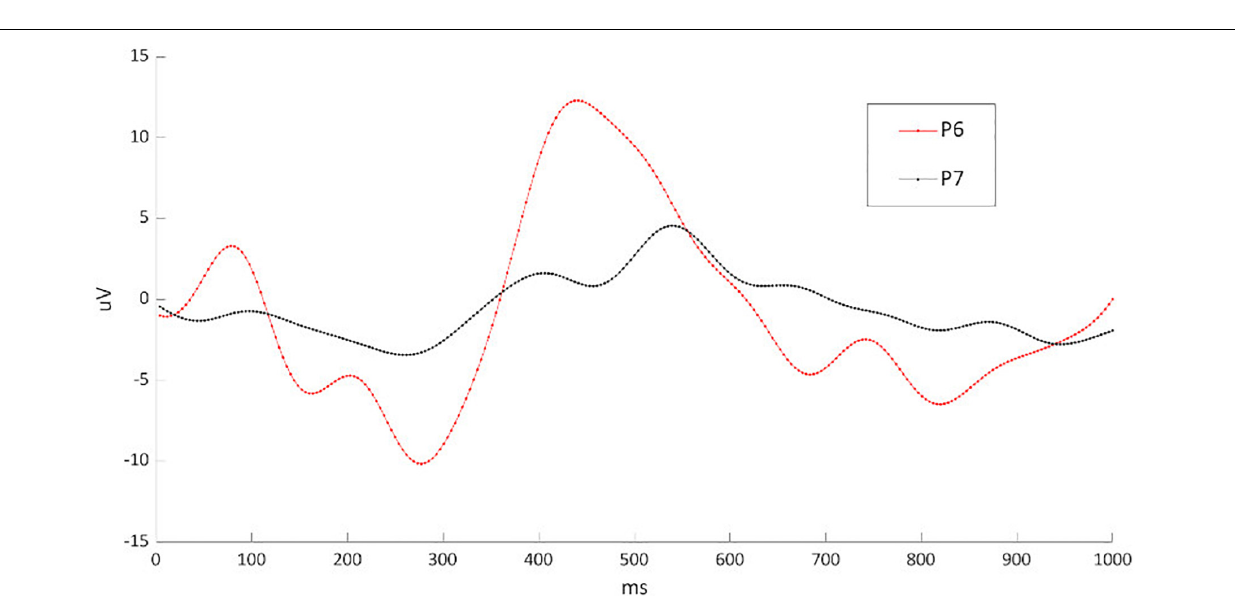
FIGURE 4 | Illustration of the P300 waveform in Pz from the participant who best controlled the h-BCI system (P6; in red) and the participant who worst controlled the system (P7; in black). EEG data sets were high-pass and low-pass filtered with cutoff frequencies of 0.1 and 10 Hz, respectively; a notch filter was used to remove 50 Hz contamination. EEG signal was segmented in epochs of 1 s starting at the onset of each stimulus. A baseline correction was done based on the average EEG activity within 200 ms immediately preceding each epoch. The average waveform for both target and non-target epochs was computed for each trial to assess P300 peak amplitude and latency. The ERP waveforms were obtained from a sample-by-sample contrast between the target and non-target ERP waveform amplitude and therefore show the difference between target and non-target; the analysis was conducted on the data sets from the six calibration